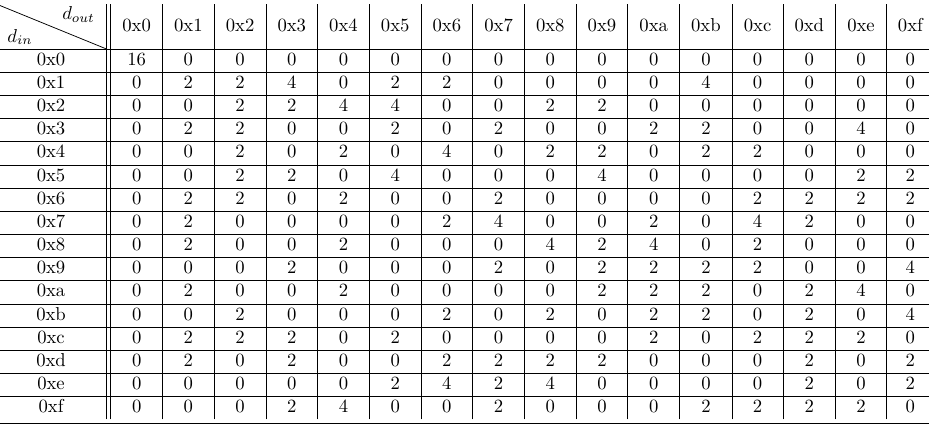
Table 13: The differential distribution table of